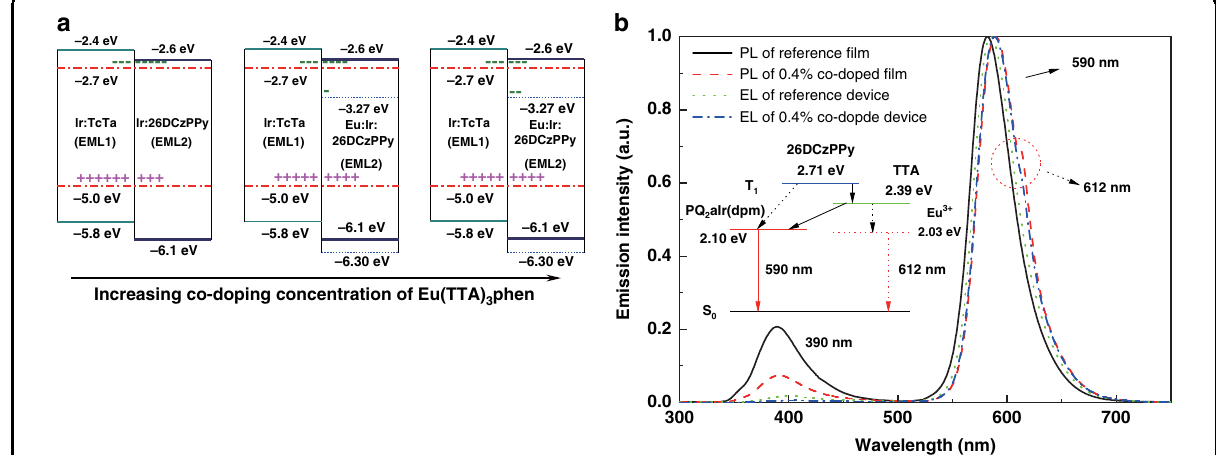
Fig. 10 Carriers ’ distribution characteristics in Eu-2 sensitized devices and the corresponding PL and EL spectra. a Carriers ’ distribution within the EMLs of sensitized devices at different co-doped concentrations. b PL spectra of reference and 0.4 wt% co-doped fi lms and EL spectra of the corresponding devices. Insert: Schematic representation of energy transfer processes within the co-doped EML. Reprinted with permission from